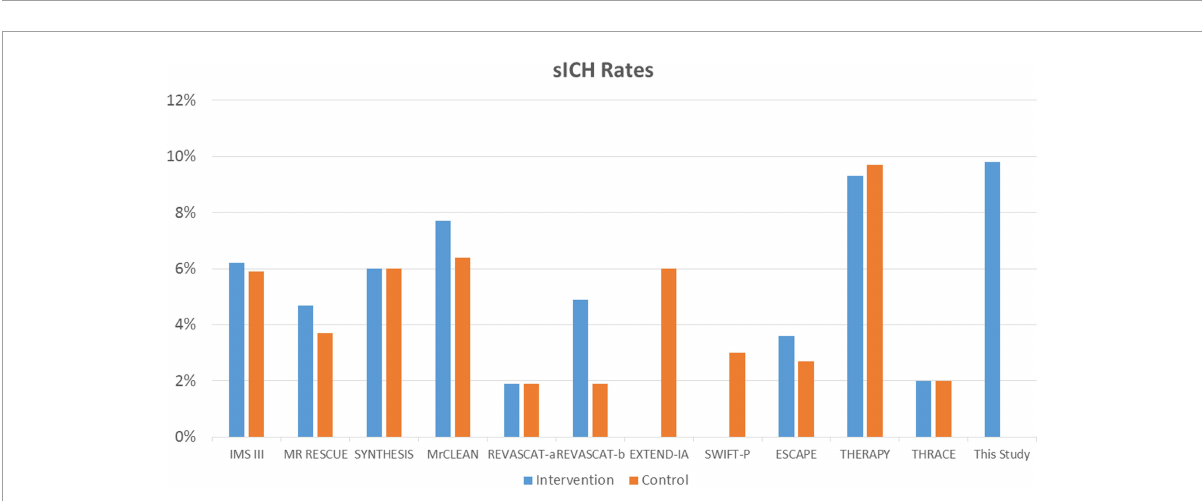
FIGURE2 Summary of randomized clinical trials assessing the effect of endovascular thrombectomy compared with standard care on sICH rates and this study. Blue: intervention and EVT. Orange: controls and standard therapy. REVASCAT-a: SITS-MOST criteria; REVASCAT-b: ECASS II criteria. PISTE study: 0% sICH, not included in the